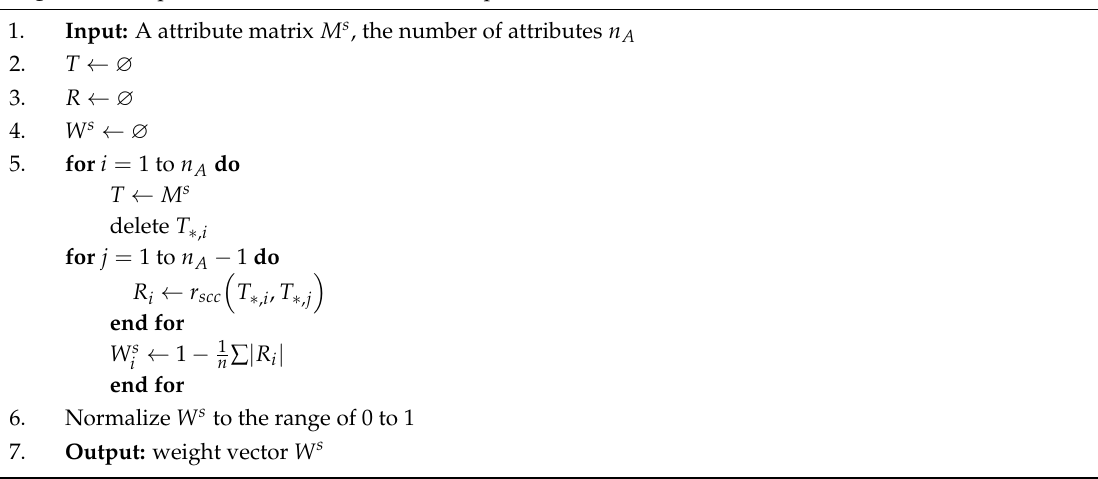
Algorithm 2: Spatial attribute fusion based on Spearman correlation coefficient